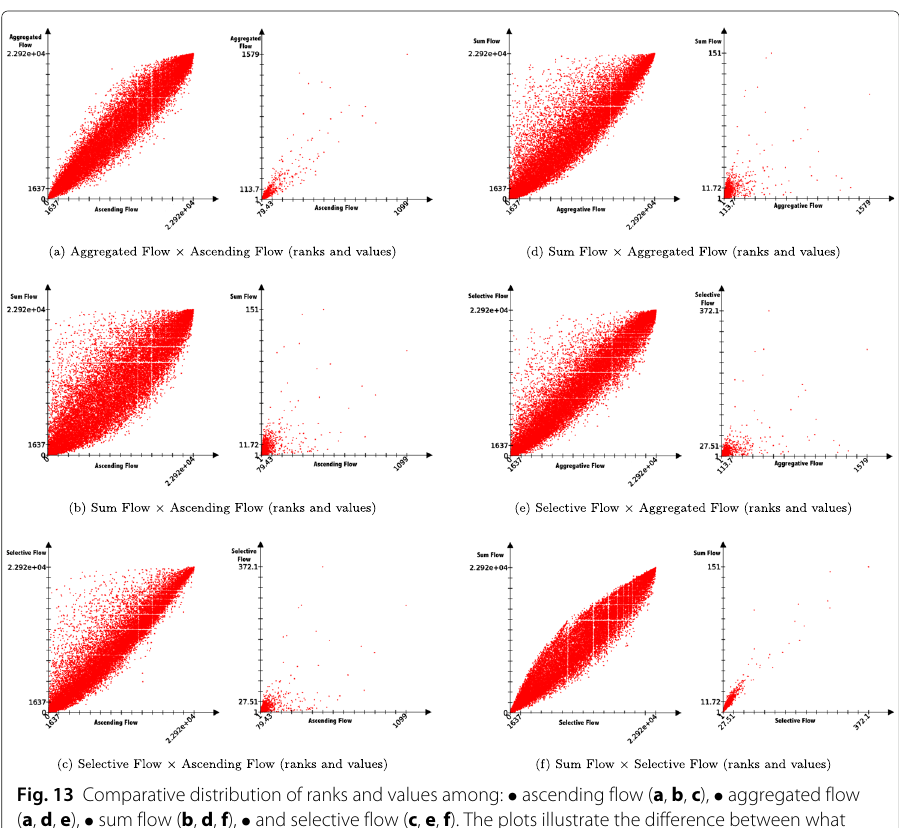
Fig. 13 Comparative distribution of ranks and values among: • ascending flow ( a , b , c ), • aggregated